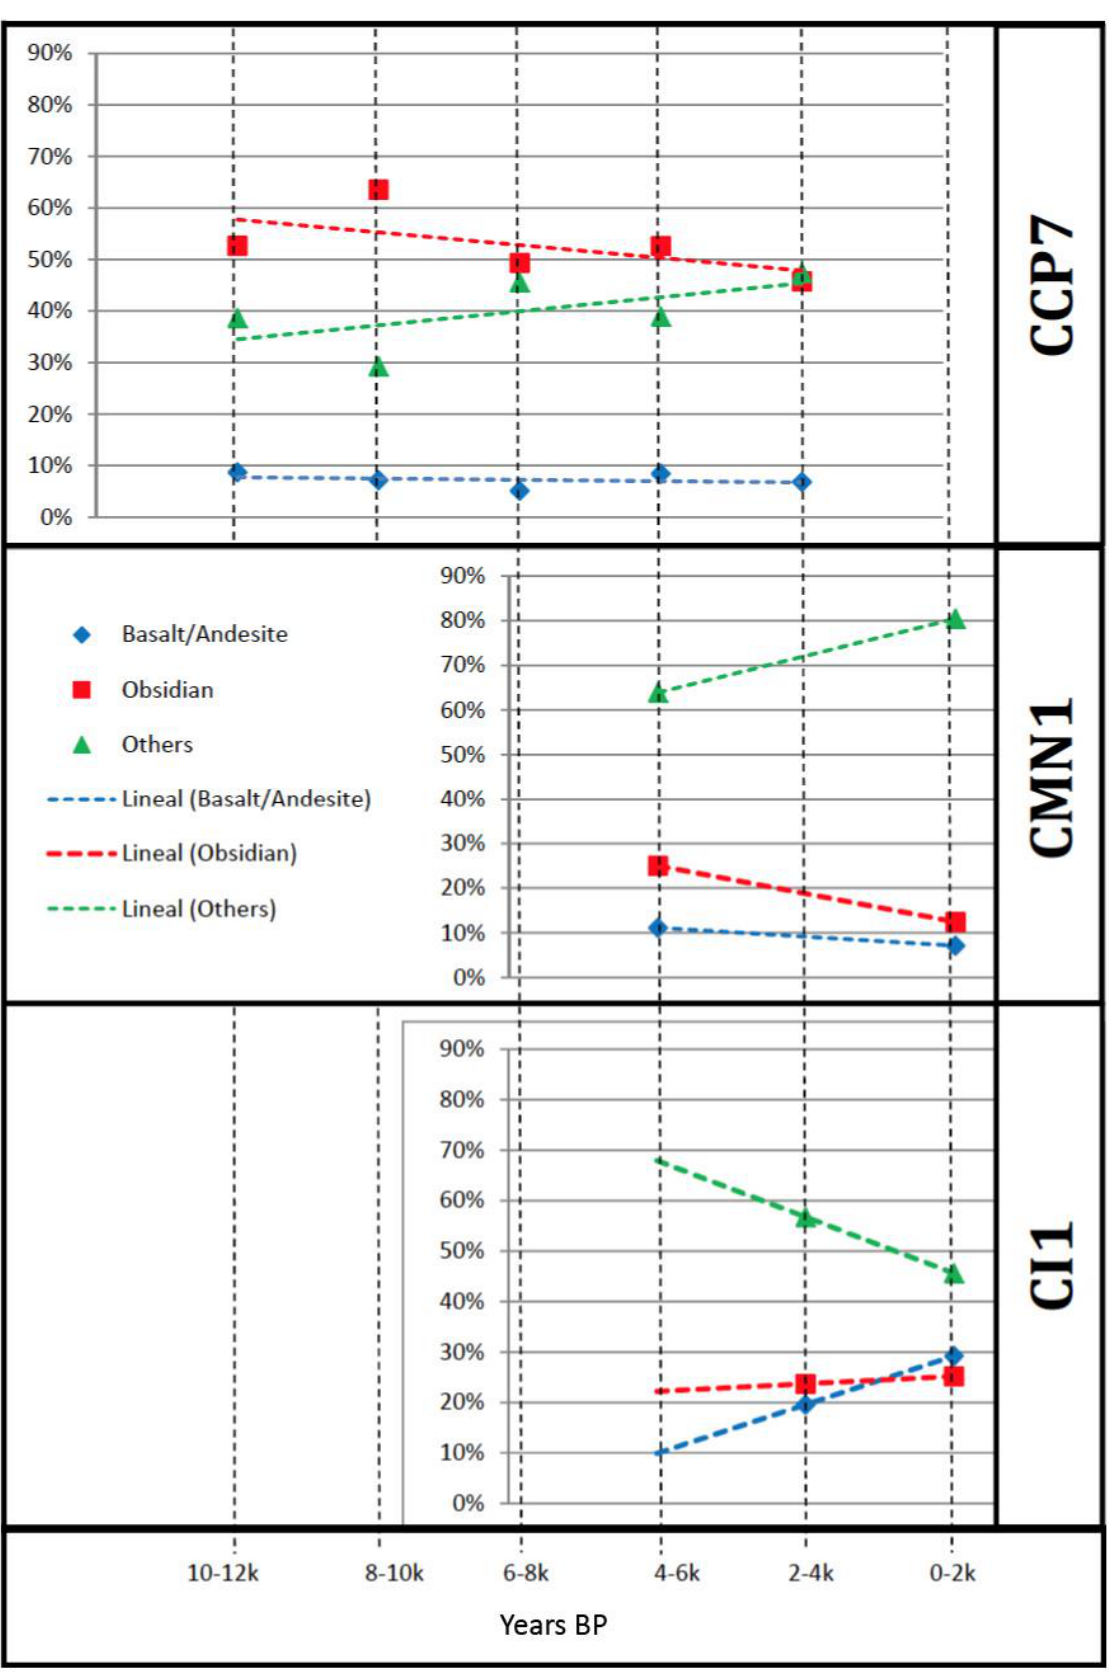
Figure 4. Selection of obsidian, andesite, and other raw materials throughout time with corresponding tendency lines. (a): CCP7; (b): CMN1; (c)